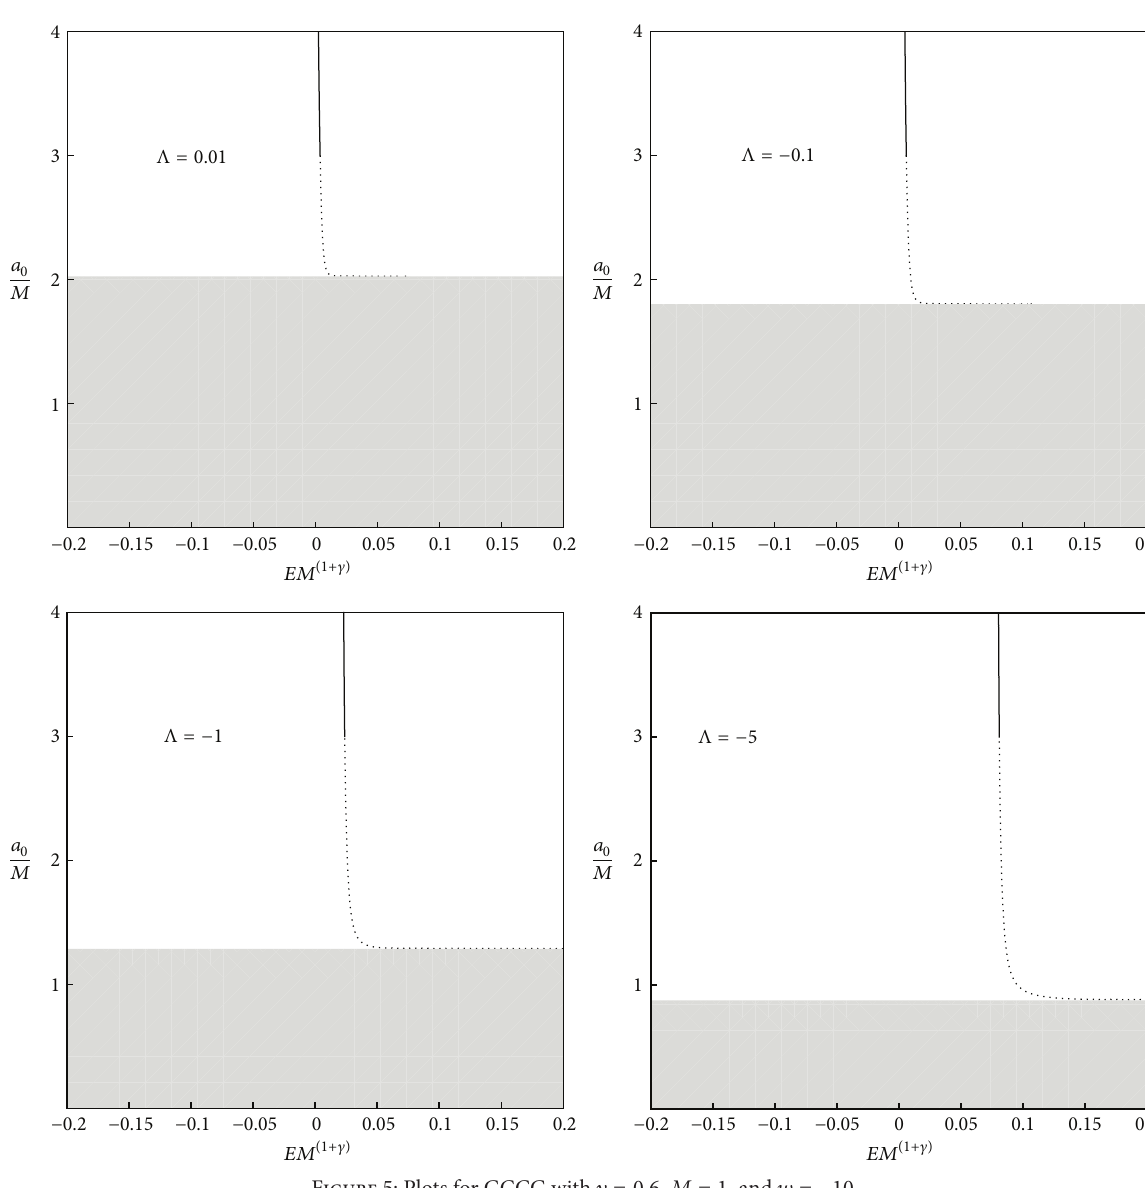
Figure 5: Plots for GCCG with 𝛾 = 0.6 , 𝑀 = 1 , and 𝑤 = −10